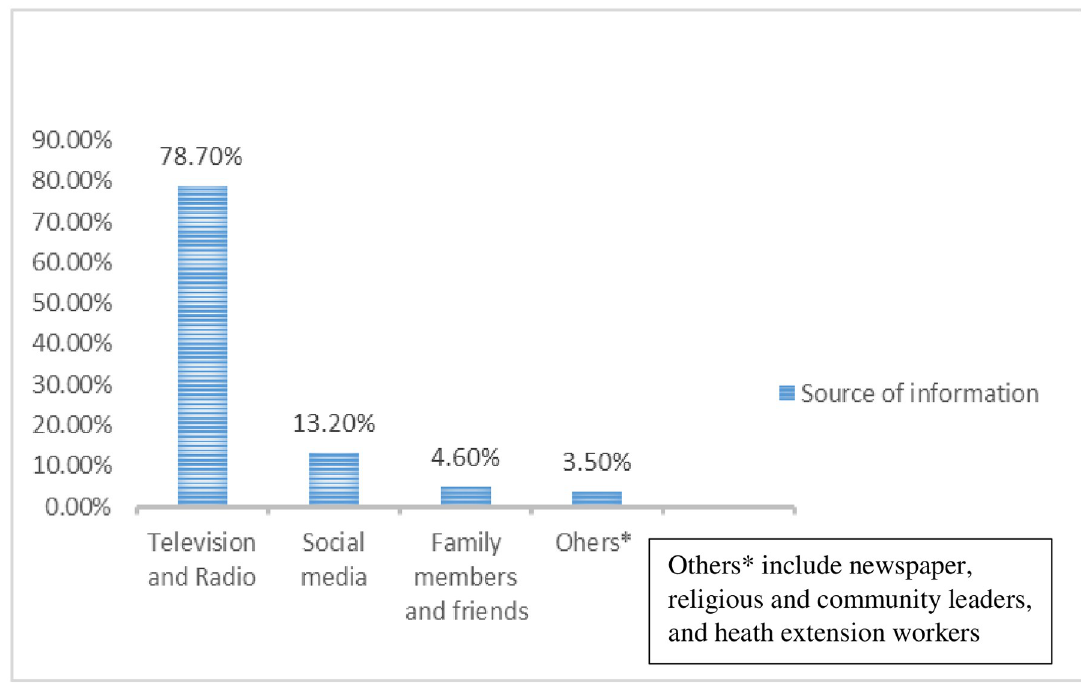
Fig 1. Source of information for students in central Gondar zone, Northwest Ethiopia,